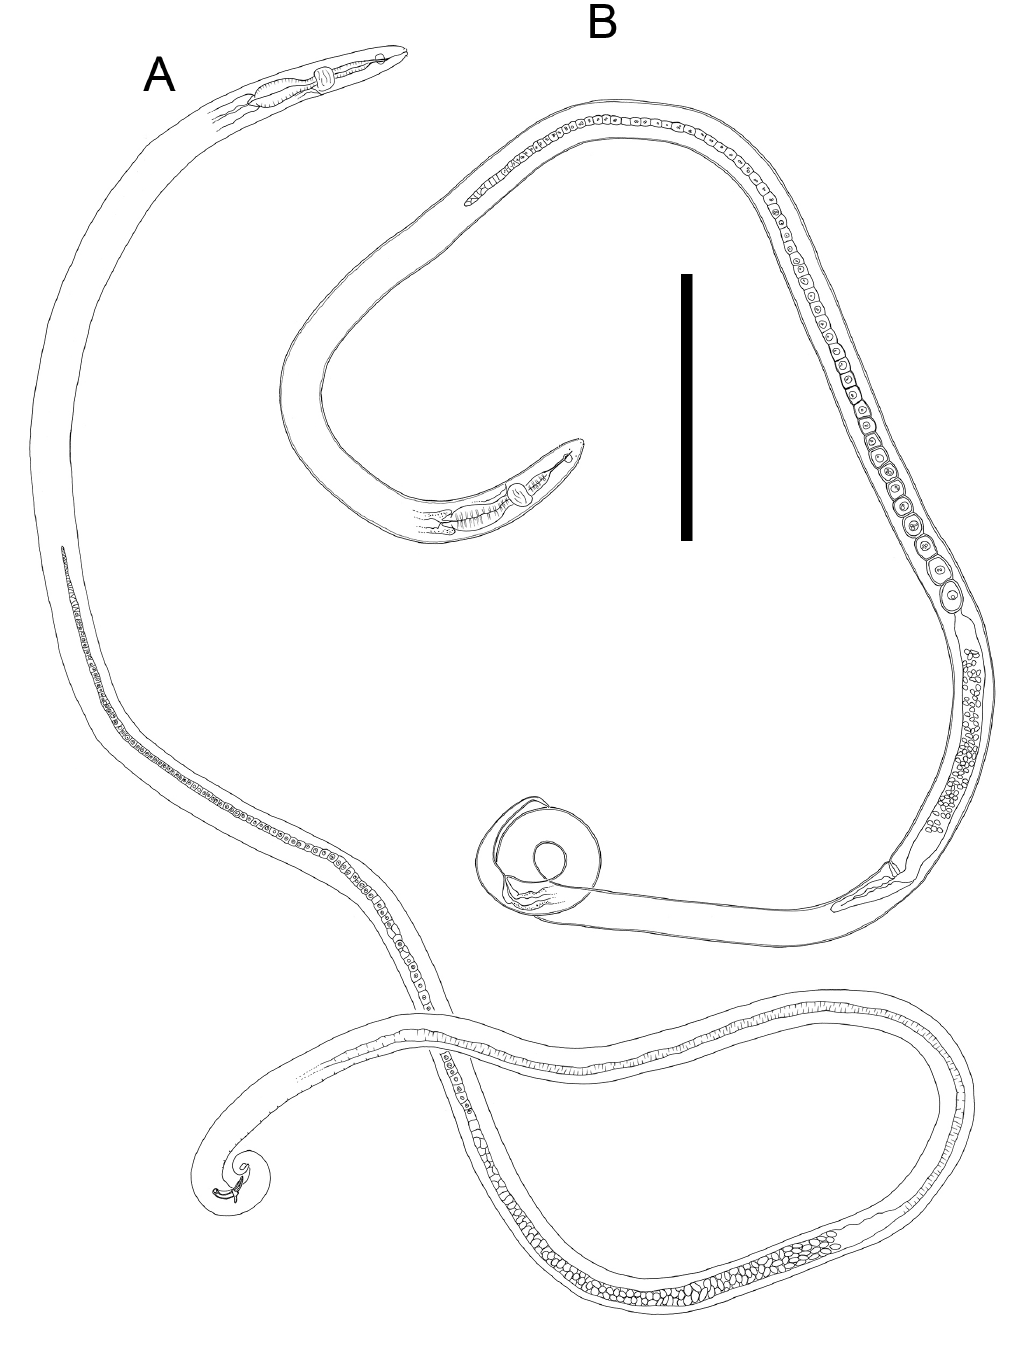
Fig. 2. Siphonolaimus curtisensillus sp. nov. A . Entire male, holotype (NIWA154903). B . Entire female, paratype (NIWA154904). Scale bar = 400